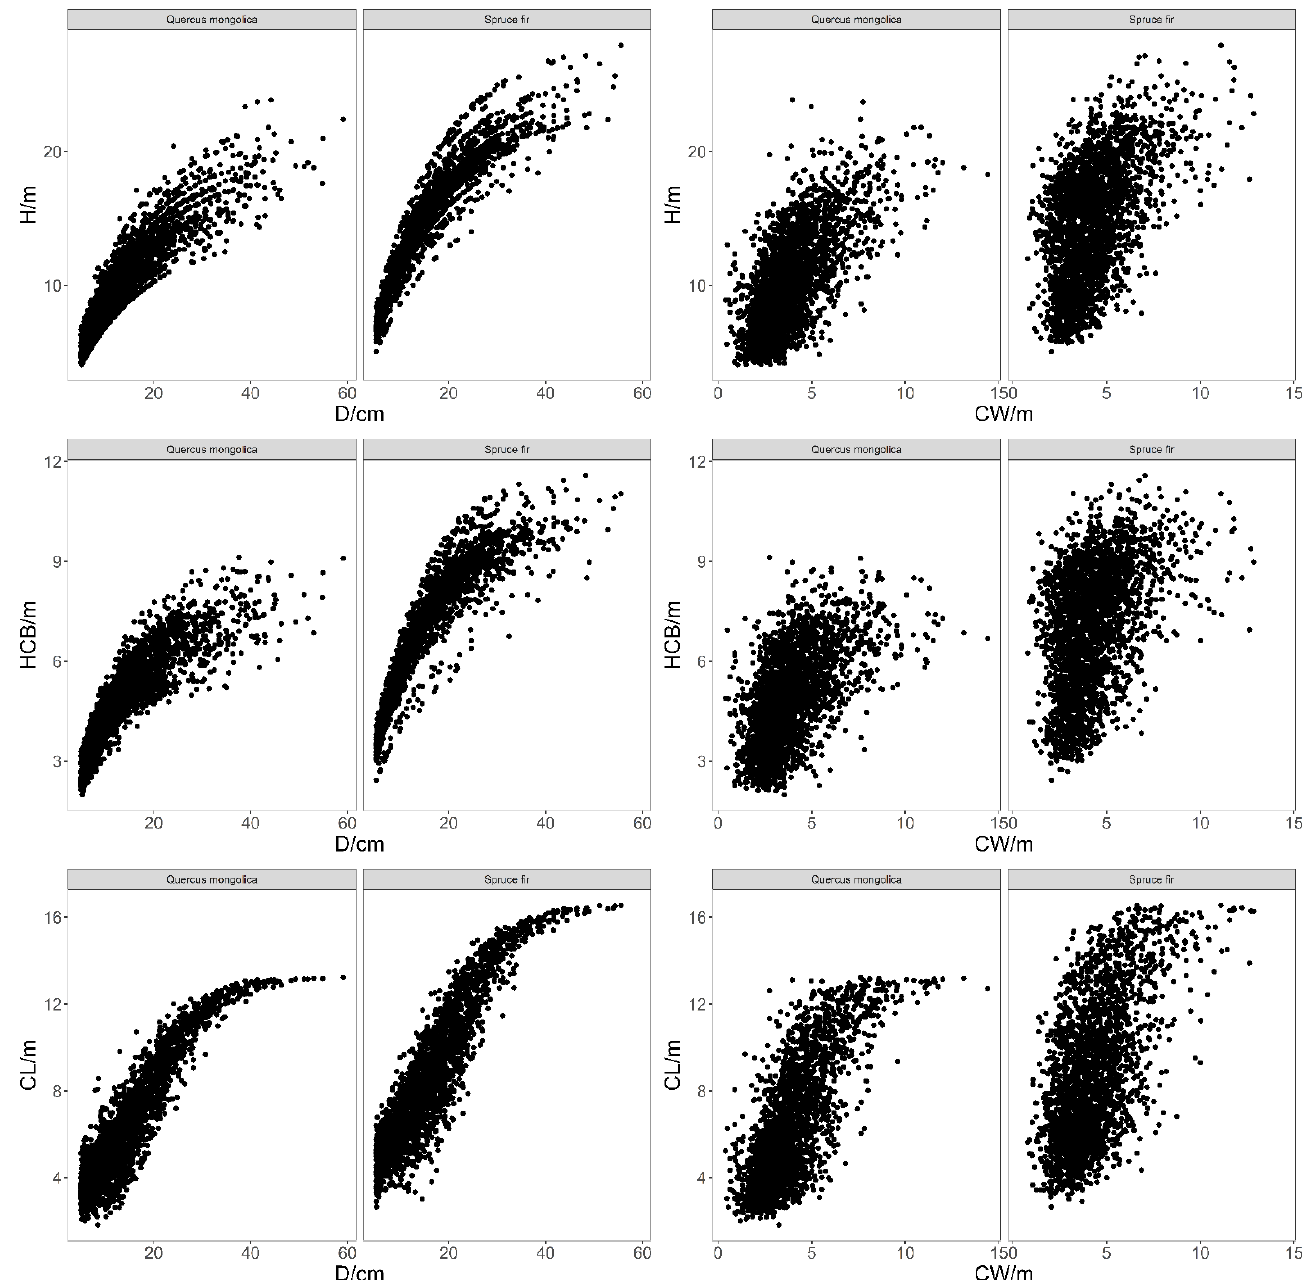
Figure 7. Predicted values of dependent variables using Equation (19) ( D : diameter at breast height (cm); CW : crown width (m)).